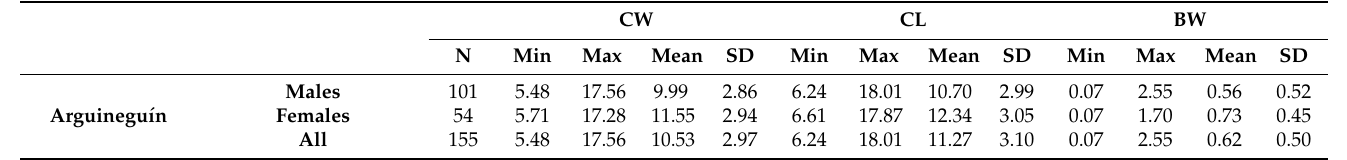
Table 1. Summary of the values of carapace length (CL), carapace widths (CW) and total weights (BW) for males and females of Percnon gibbesi caught off Gran Canaria. N: number of individuals, Min: minimum, Max: maximum, SD: standard